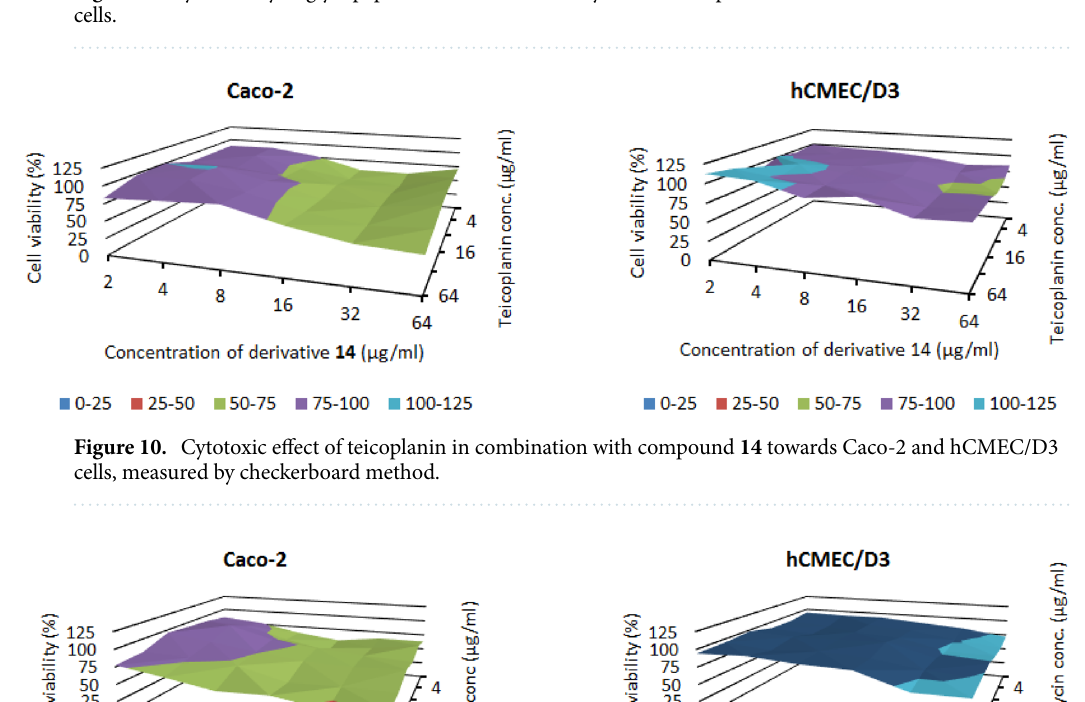
Figure 9. Cytotoxicity of glycopeptide antibiotics vancomycin and teicoplanin towards Caco-2 and hCMEC/D3 cells.